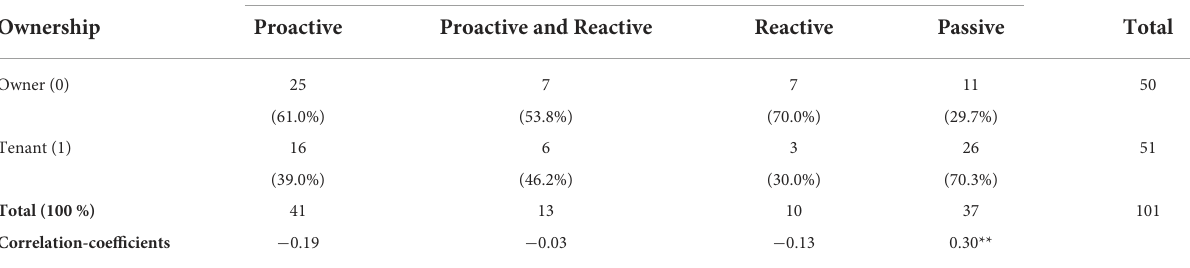
Adaptation Strategy